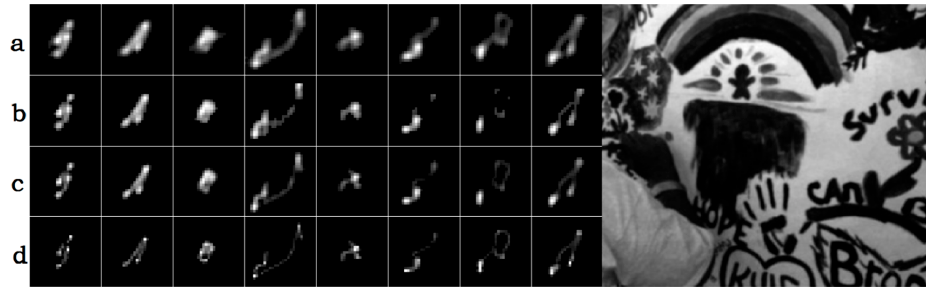
Figure 7. Comparison of the estimated kernels. ( a ) results of Fergus et al. [3]; ( b ) results of Xu and Jia [7]; ( c ) our results; and ( d ) the ground truth blur kernels.